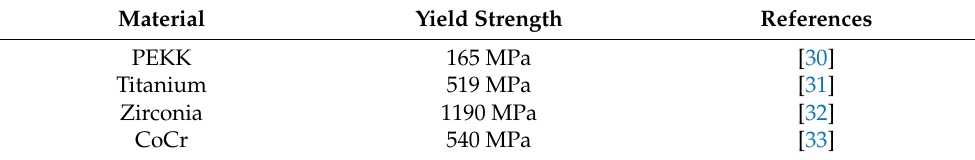
Table 3. Yield strength of crown materials.